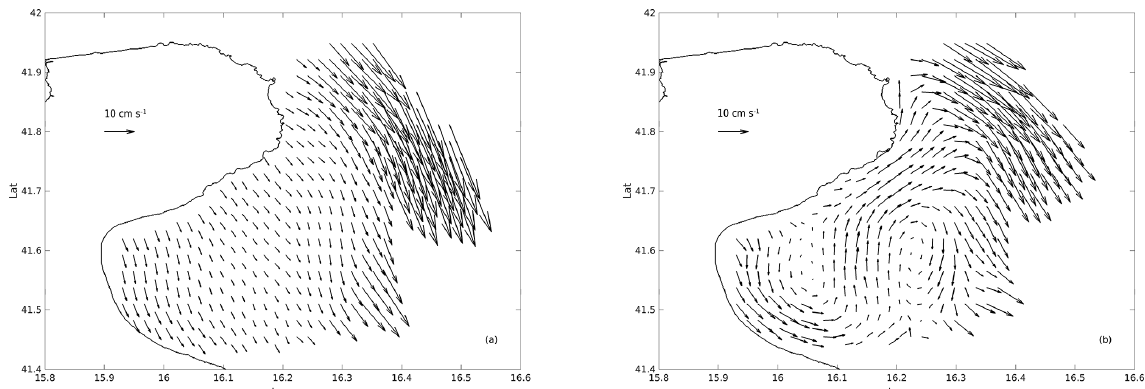
Figure 2. Mean surface currents in the Gulf of Manfredonia measured by the Istituto di Scienze Marine (ISMAR) HF radar network. (a) October 2013: currents are dominated by a large-scale pattern; (b) February 2014: many different small-scale structure are